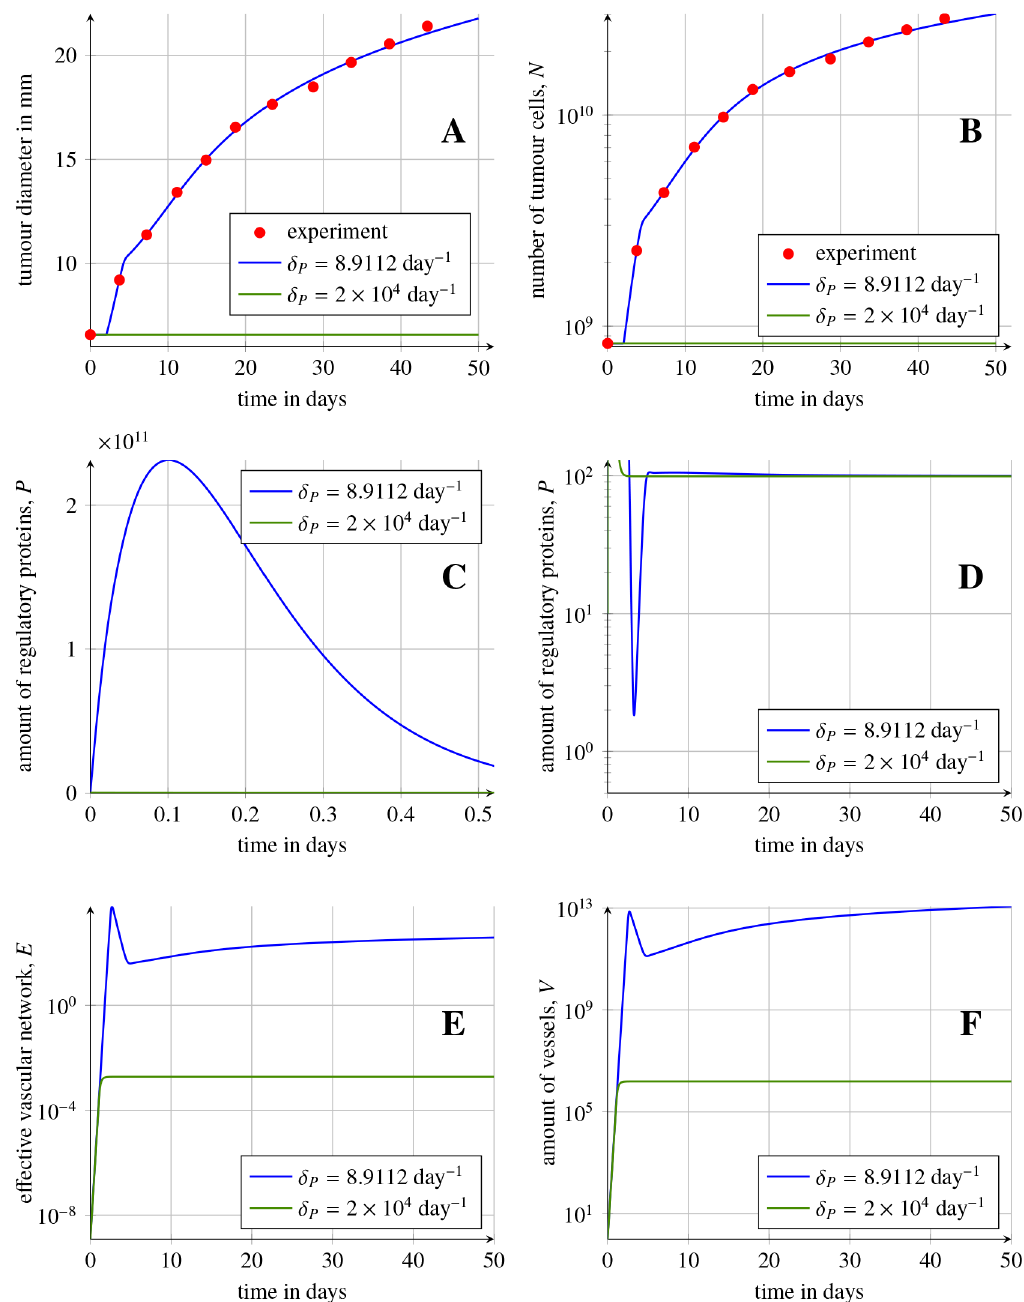
Fig 9. Lewis lung cancer growth prediction during the first month. (A) and (B), comparison of the experimental tumour Lewis lung cancer data from [38] (red circles) and solutions of model (23) for δ P = 8.9112 day − 1 (blue lines) for the best fitted parameters, with MSE error equal to 0.07%. (C), (D), (E) and (F), comparison of solutions P * , E and V * of system (23) with δ P = 8.9112 day − 1 (blue lines). Solid green lines show the behaviour of the model for a high the model has only one stable steady state with a small suppression of VEGF ( δ P = 2 × 10 4 day − 1 ). For δ P > δ P cr ,2 amount of tumour cells. Rest of parameters are given in Table